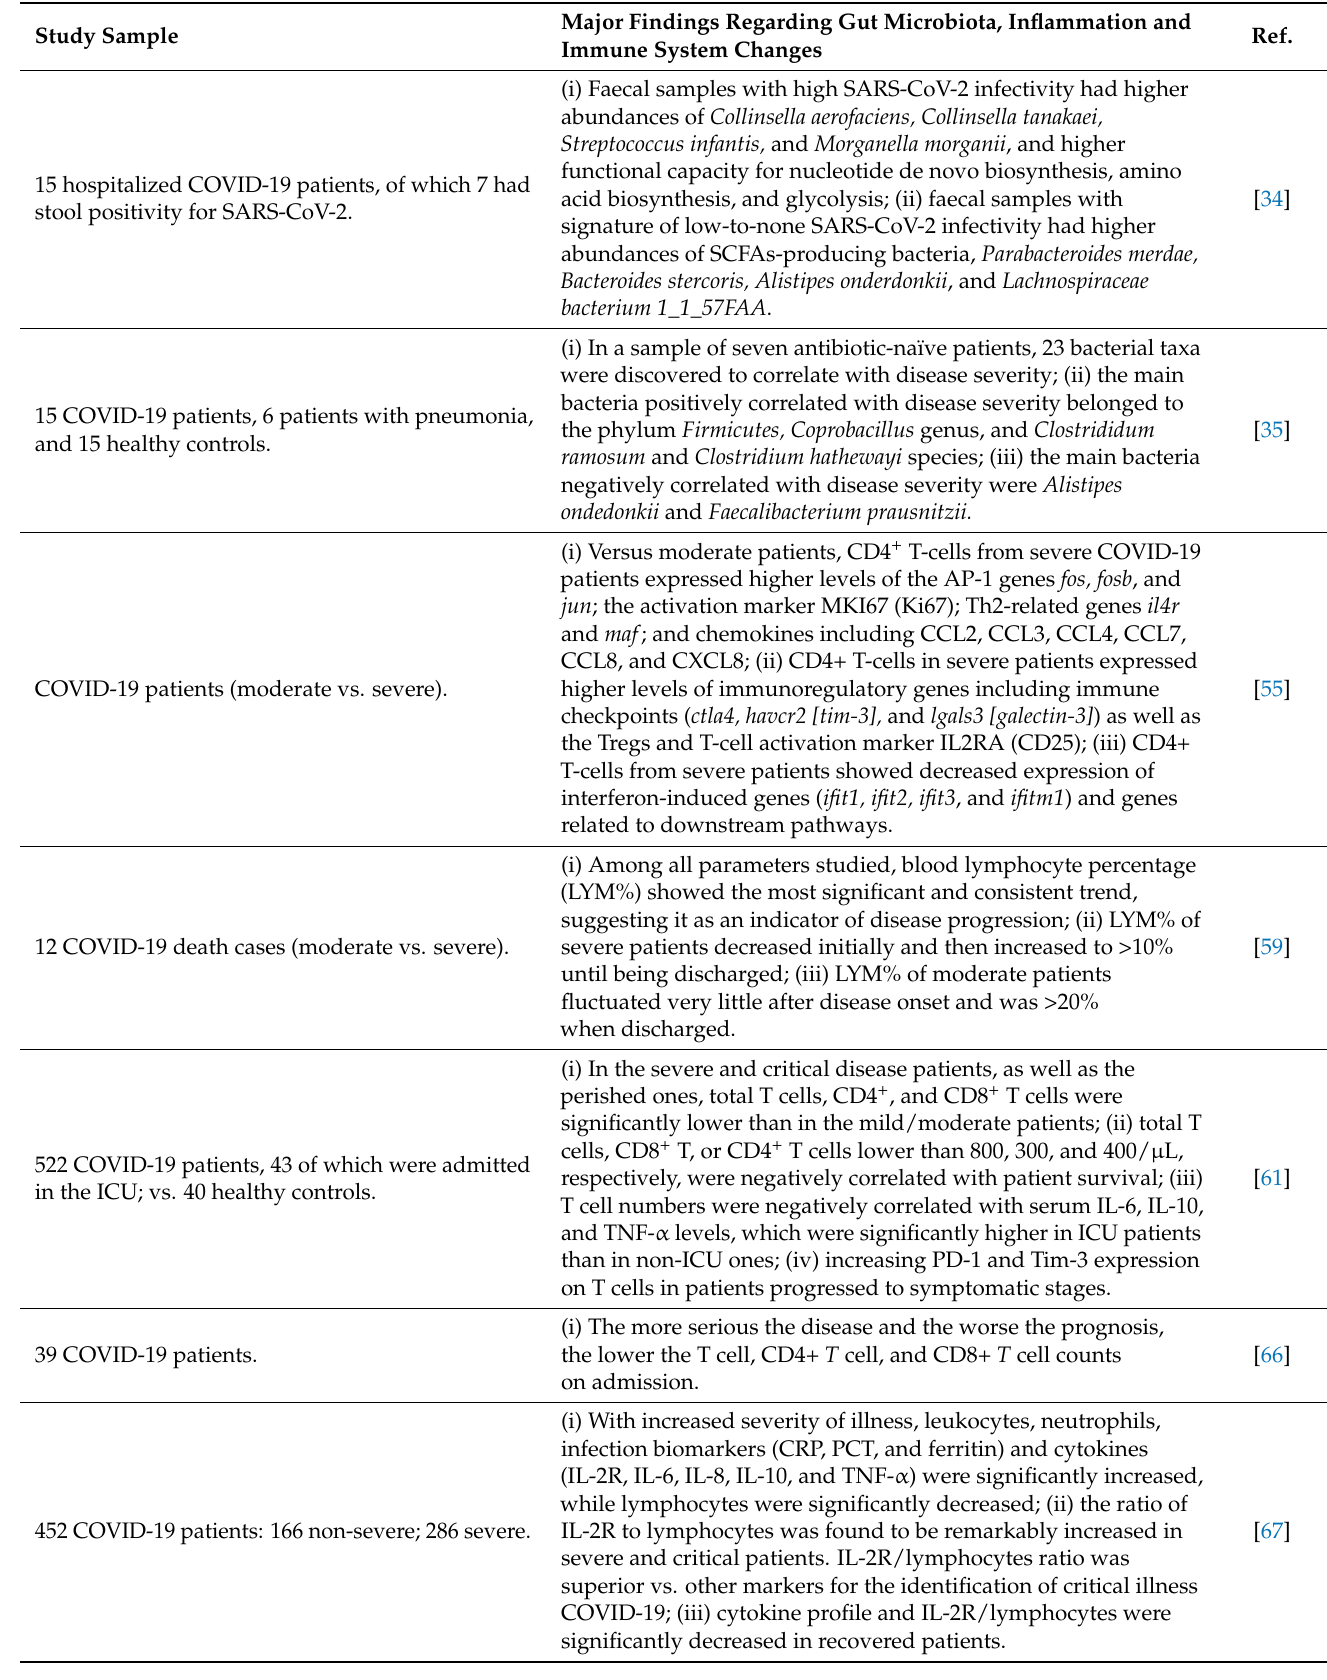
Table 1. Cont . Major Findings Regarding Gut Microbiota, Inflammation and Immune System Changes